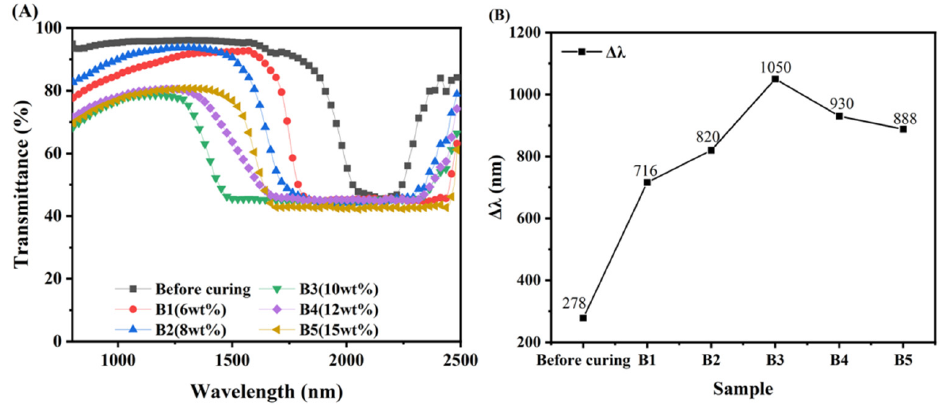
Figure 7. Transmission spectra ( A ) and Δλ of samples B1-B5 ( B ).